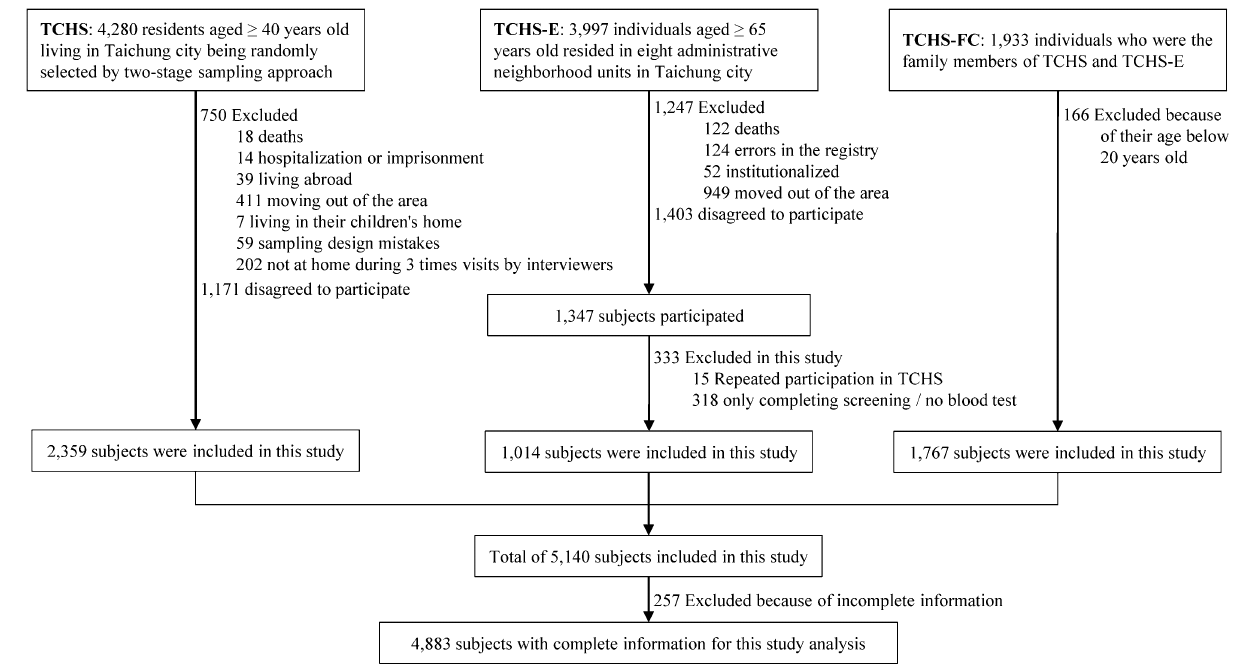
Figure 3. Flowchart of the study’s recruitment. TCHS Taichung Community Health Study, TCHS-E Taichung Community Health Study-Elderly, TCHS-FC Taichung Community Health Study-Family